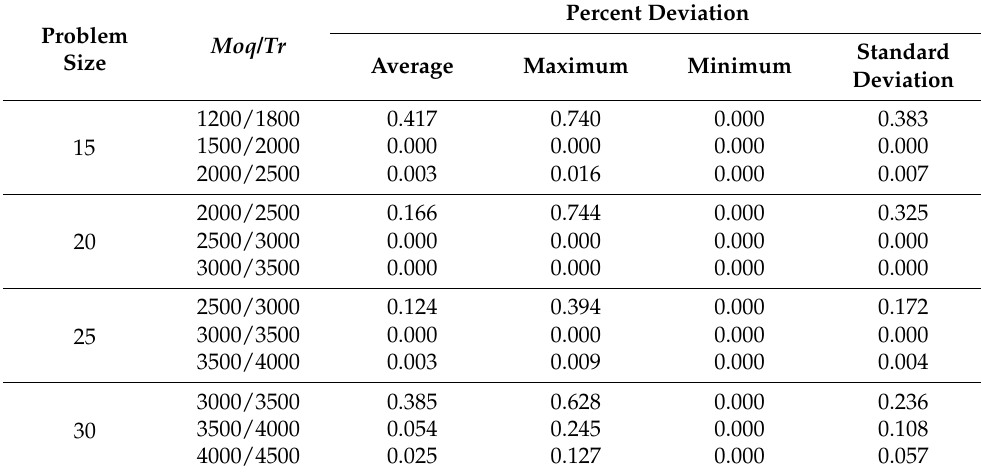
Table 7. Output of percent deviation in Experiment II.